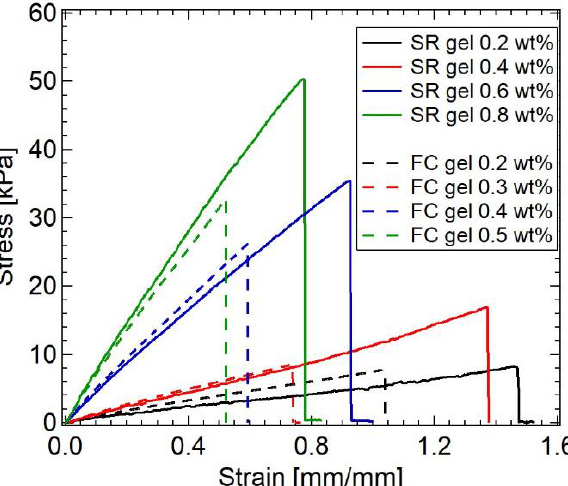
Figure 2. Stress – strain curves for FC and SR gels with different cross-linker concentrations. Reprinted from [23] with permission from American Chemical Society.